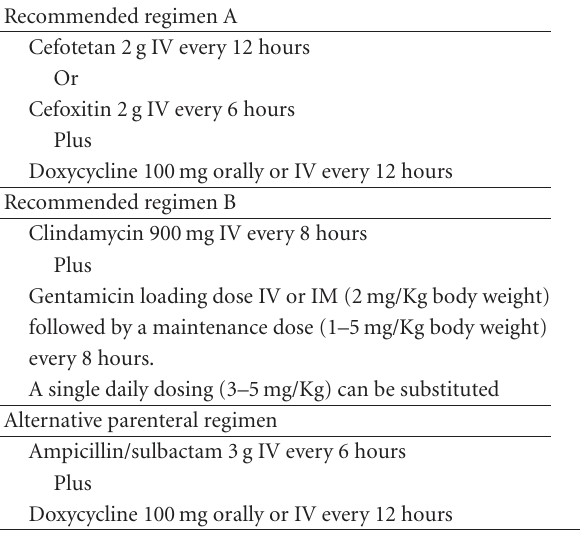
Table 2: Parenteral treatment recommendations for acute pelvic inflammatory disease a .